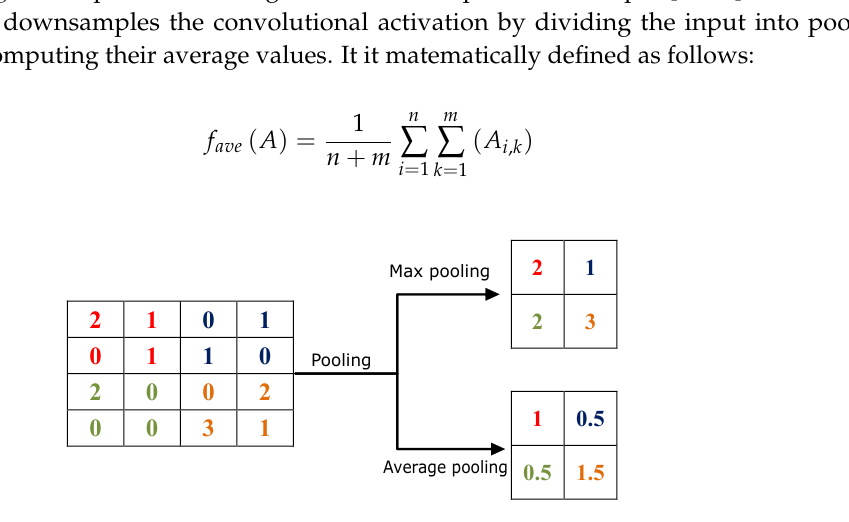
Figure 6. Examples of pooling operations by using a 2 × 2 filters applied with a stride of 2. Dropout layer: it is a regularization layer that randomly drops neuron units of the